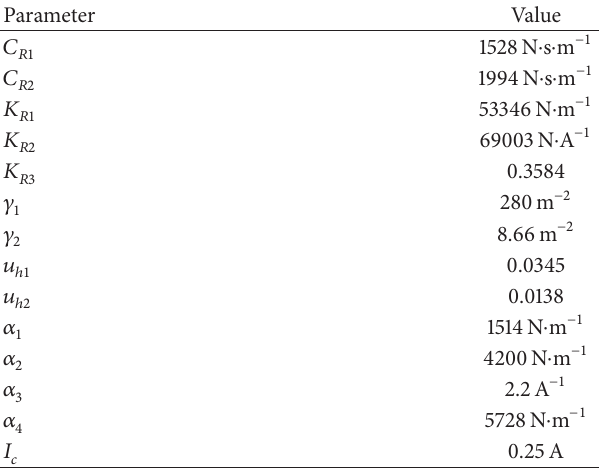
Table 2: Parameters of Bouc-Wen model. Table 3: Parameters of Bingham